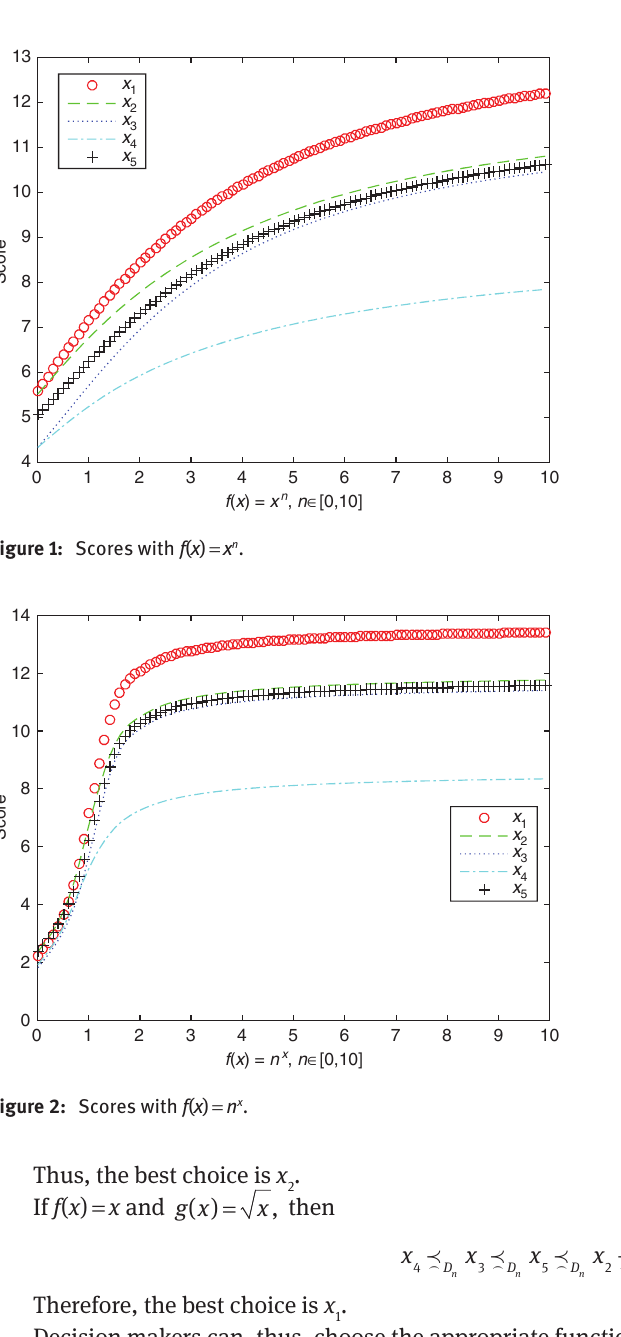
Table 6: Synthetic Evaluation Value of the Group. f ( x ) = x g ( x ) = x 2 ( ) g x x = = { s x A , s , s 1 1 6.380004 6.827676 7.28195